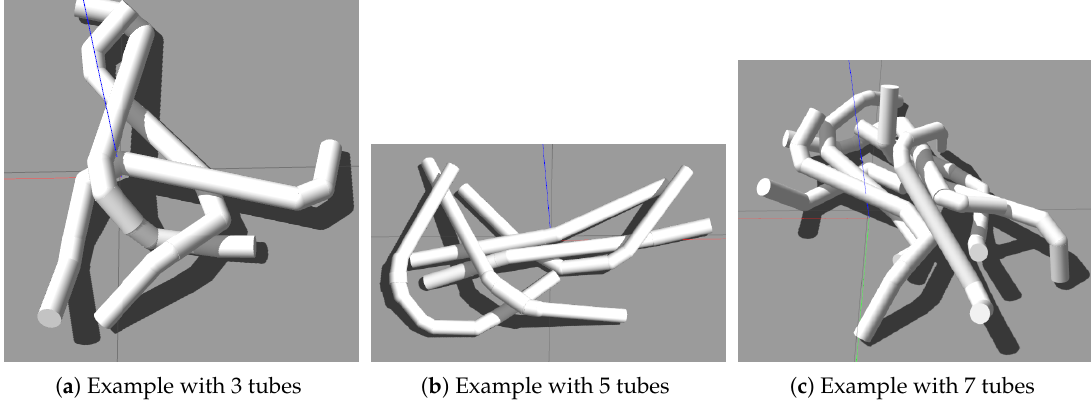
Figure 1. Examples of sets of simulated tubes in Gazebo Figure 4. Examples of sets of simulated tubes in